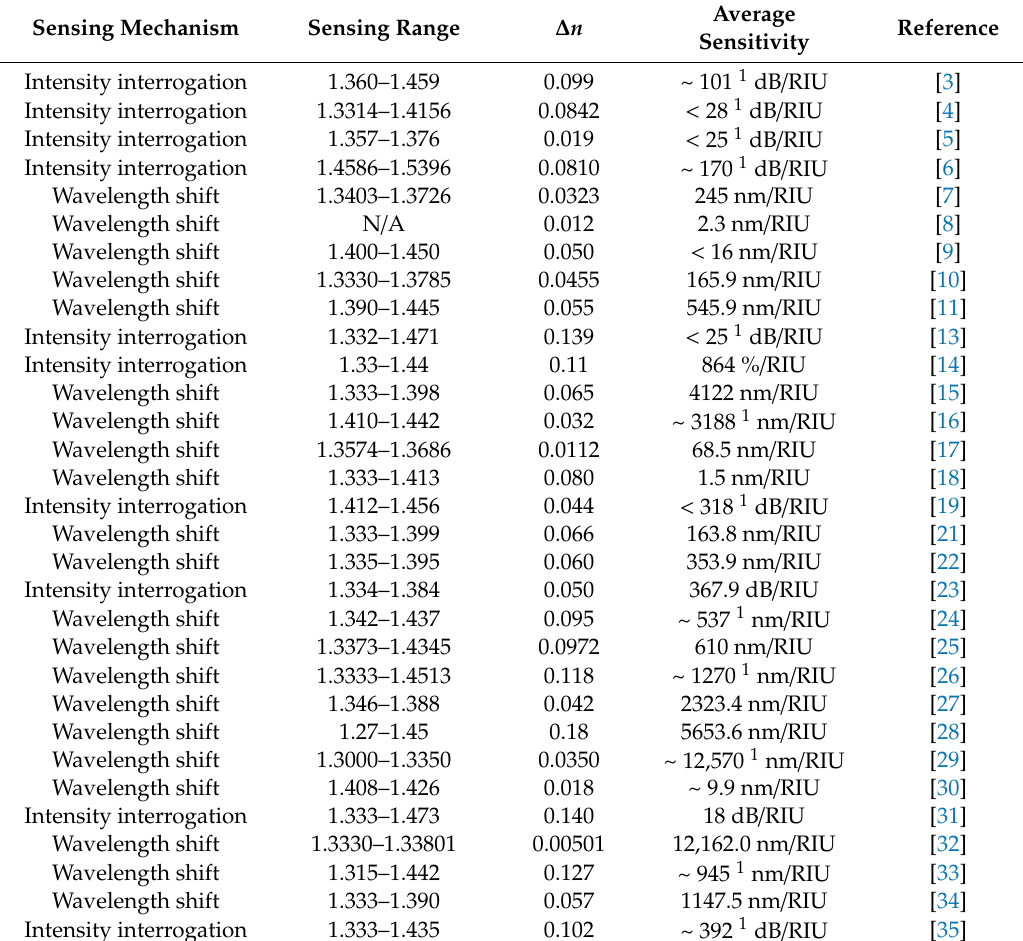
Table A1. Performance comparison for the previously reported RI